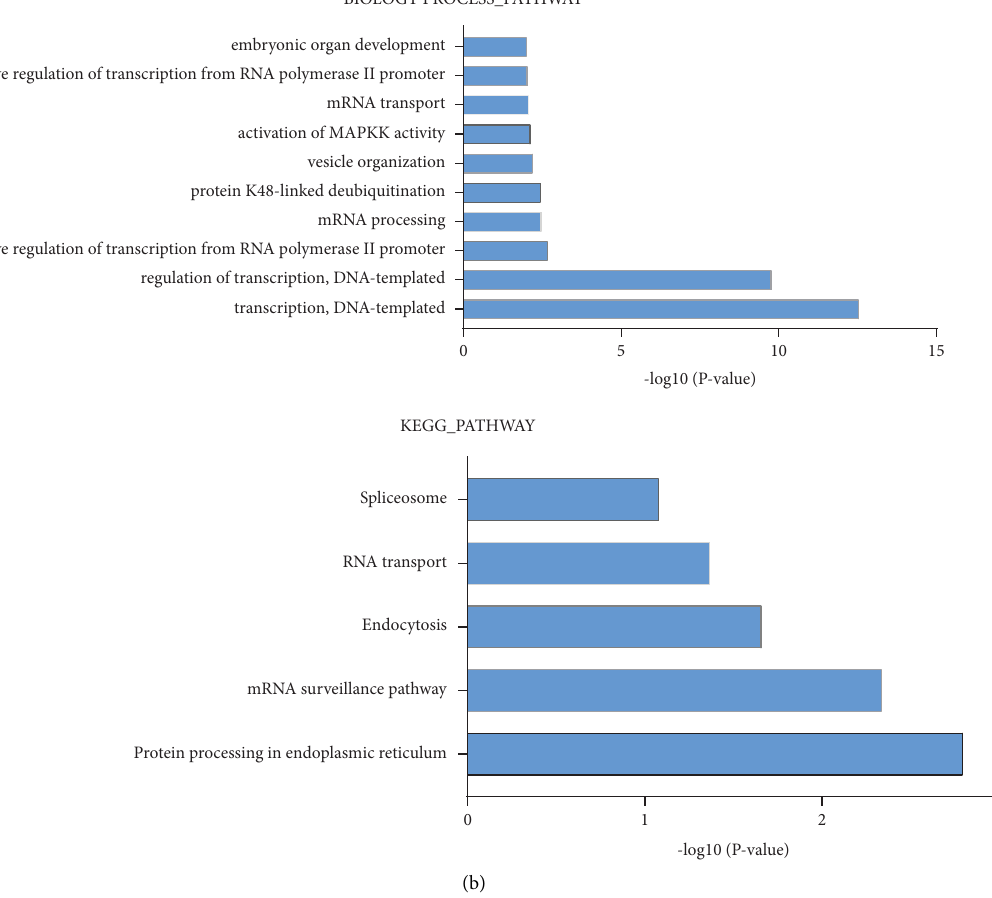
Figure 6: Te miRNA-mRNA network. (a): Te miRNA-mRNA network is composed of 3 miRNAs and 218 mRNAs. Triangles and circles represent miRNAs and mRNAs, respectively. Te green circles represent genes shared by two or more miRNAs. (b): Te top ten BP term in GO and KEGG functional pathway enrichment